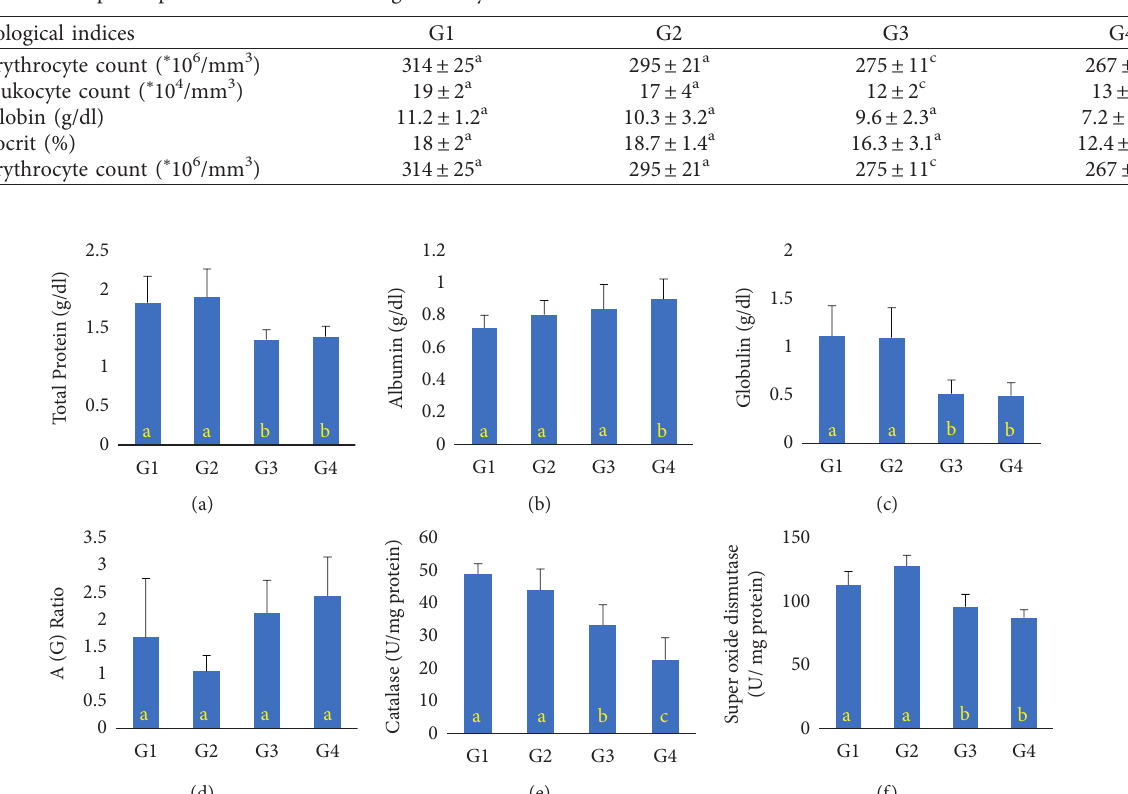
Table 4: Summary of hematological parameters: G1 (control), G2 (AsNPs 1mg/l), G3 (AsNPs 10 mg/l), and G4 (AsNPs 20mg/l). Values with a different superscript in the same row are significantly different.